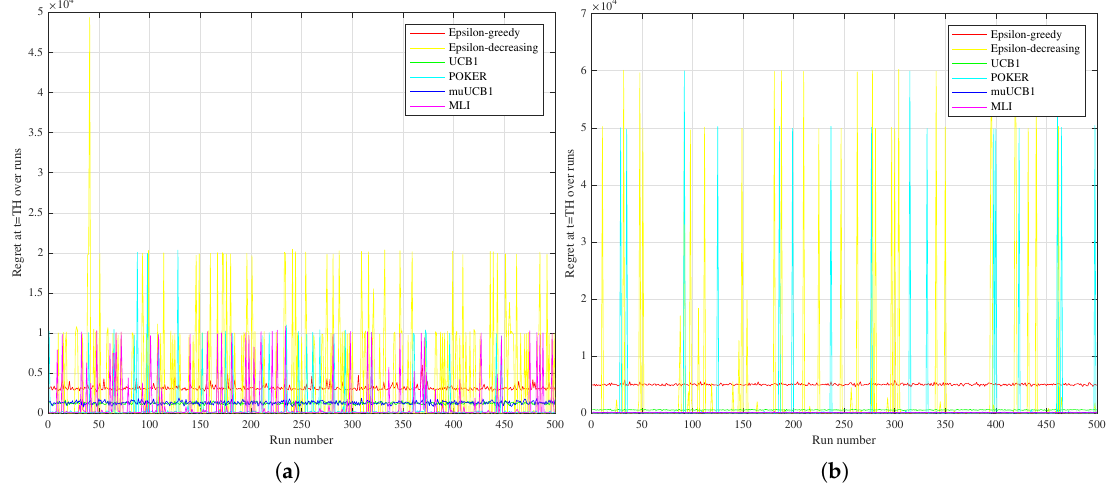
Figure 10. Regret achieved by the six considered algorithms at the time horizon as a function of the run, with a Bernoulli distribution for the reward PDF and T U / T M = 5. ( a ) Hard configuration; ( b ) Easy